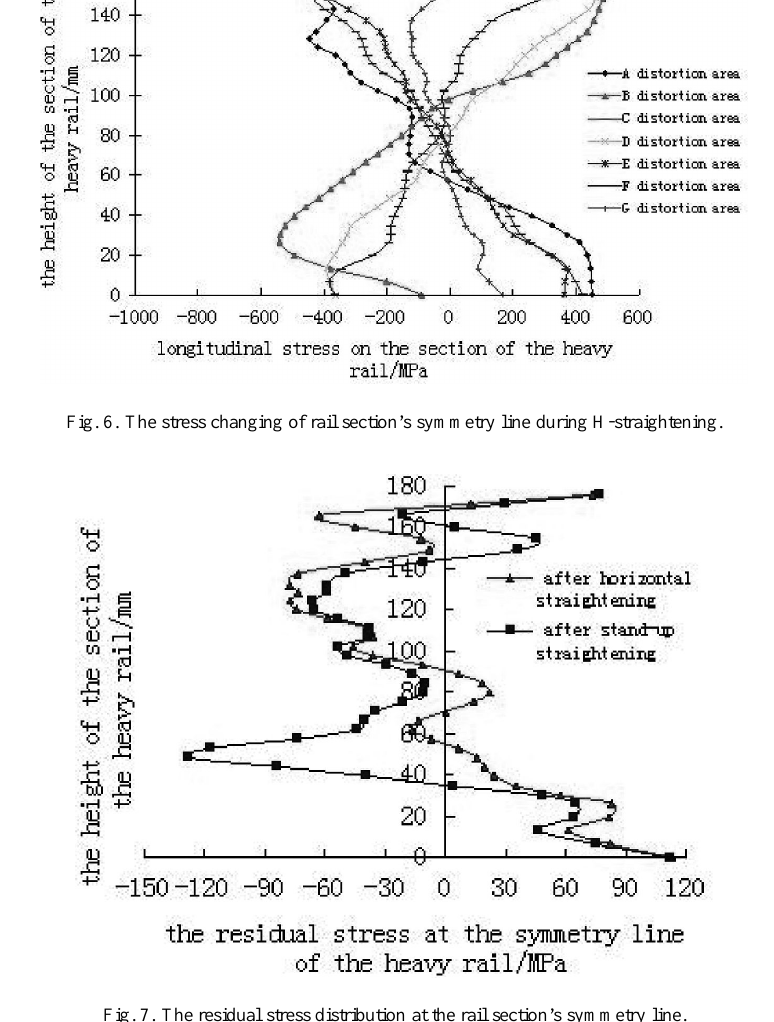
Fig. 7. The residual stress distribution at the rail section’s symmetry